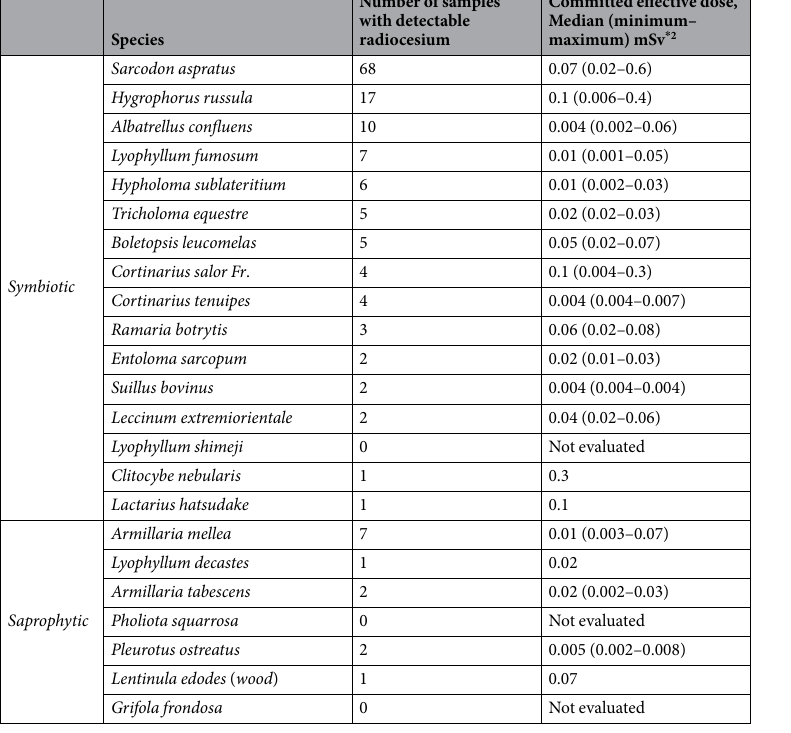
Table 2. Committed effective dose due to wild mushroom intake in